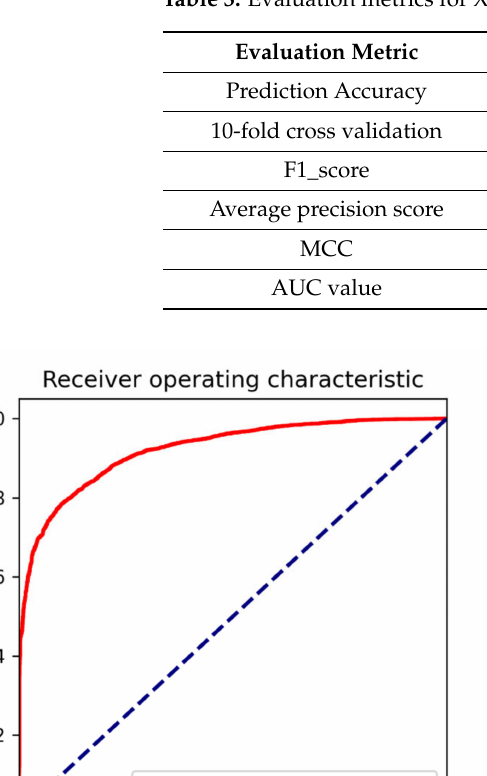
Table 3. Evaluation metrics for XGBoost classifier models.